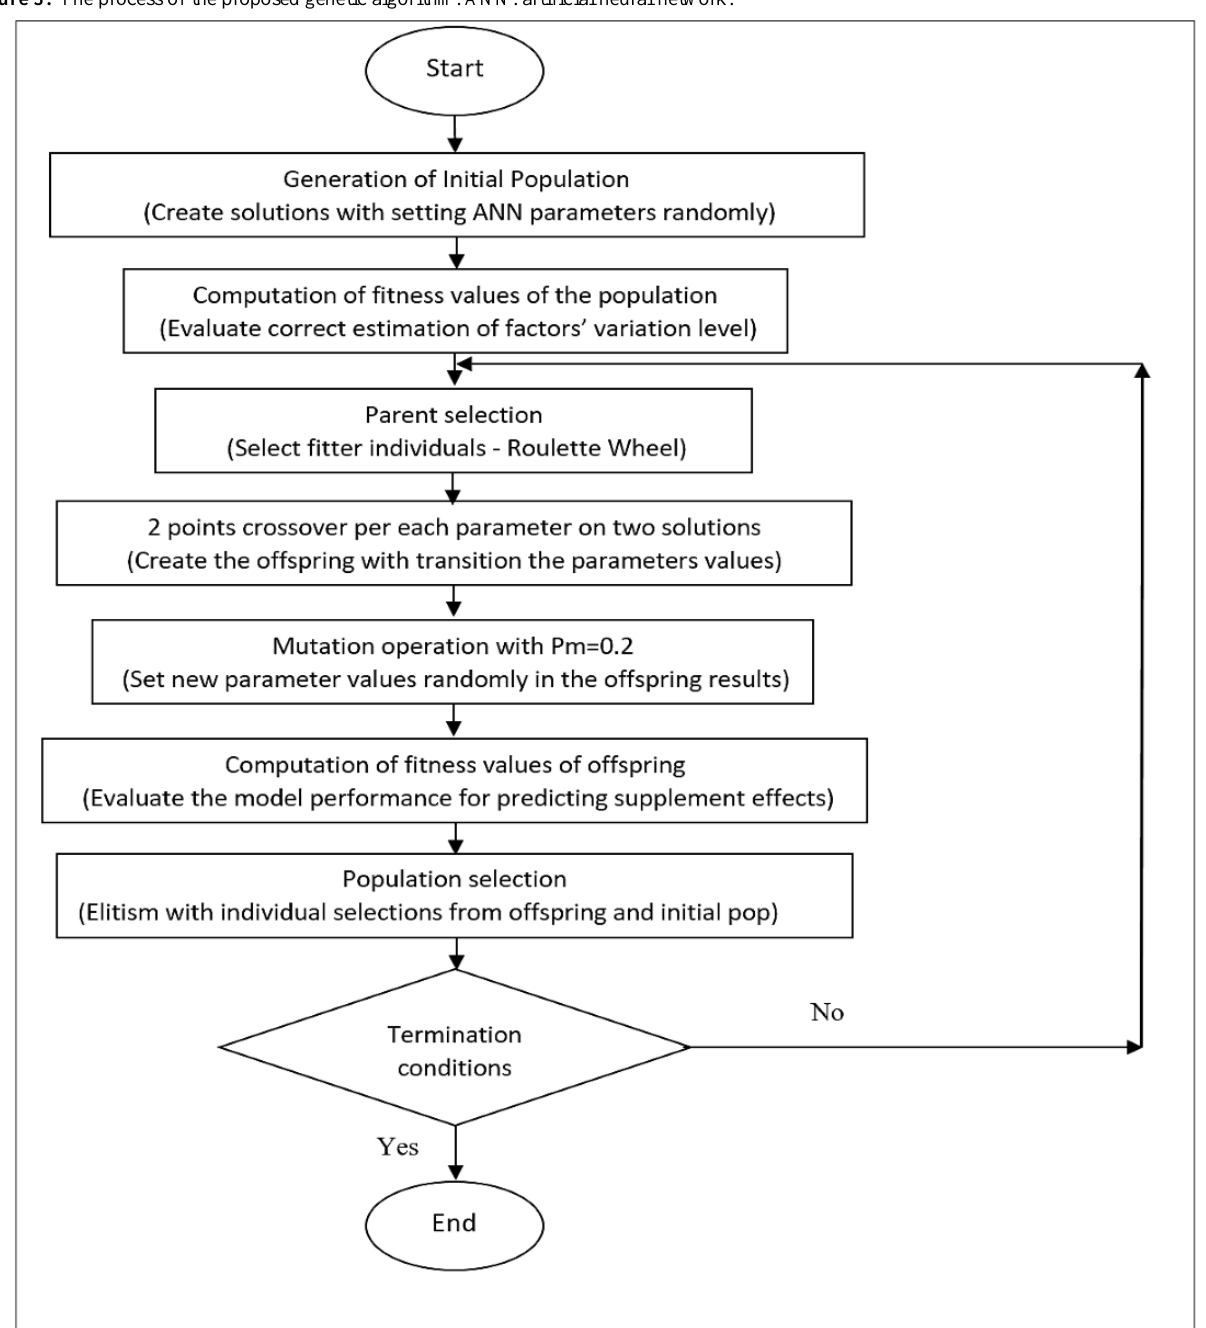
Figure 3. The process of the proposed genetic algorithm. ANN: artificial neural